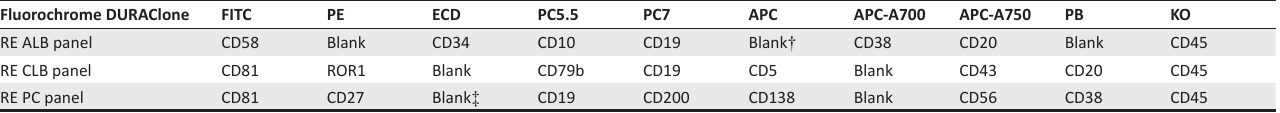
TABLE 2: Possible reagent selection for method comparison according to suspected target population validated at the Charlotte Maxeke Johannesburg Academic Hospital flow cytometry laboratory in Johannesburg, South Africa, April 2020 to August 2020. Fluorochrome